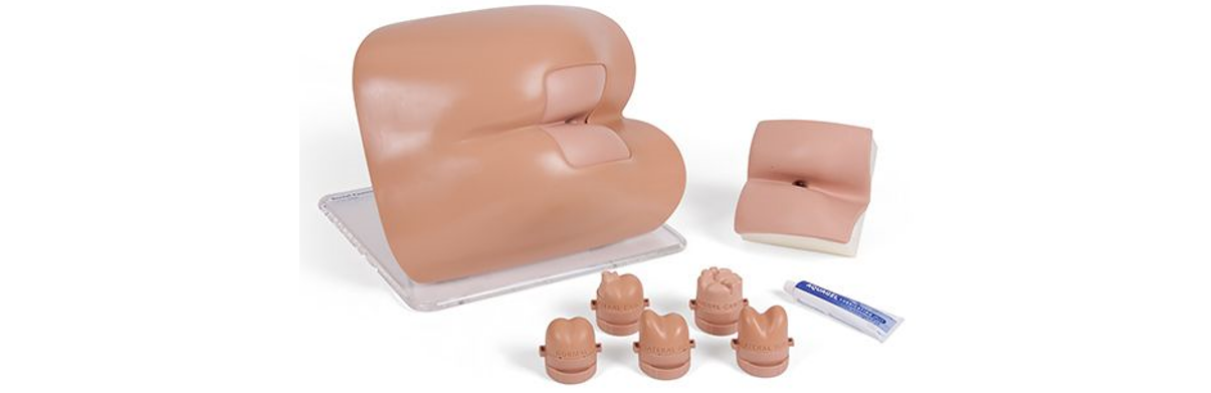
Figure 1. A standard benchtop model used in medical schools for teaching and practicing digital rectal